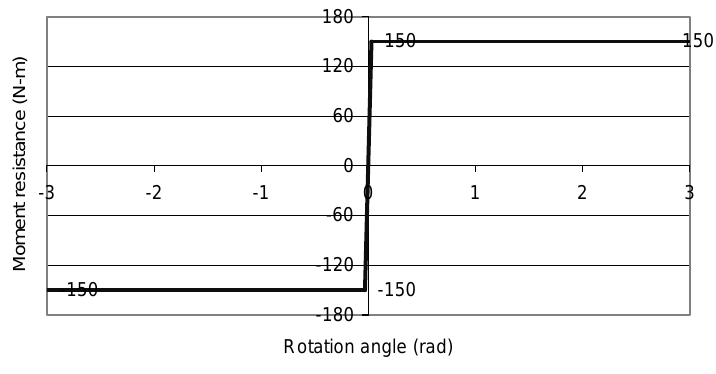
Fig. 3. Rotation-angular resisting torque imposed at the center of driven